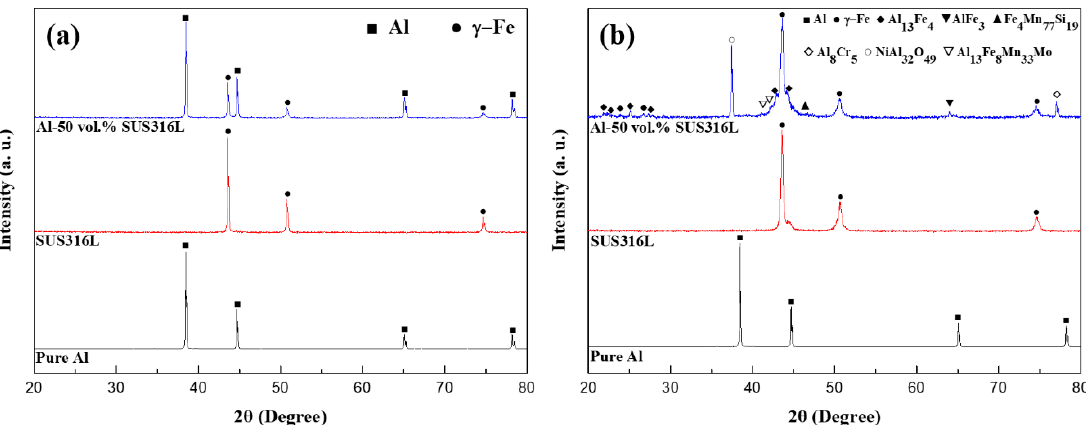
Figure 3. XRD patterns of ( a ) pure Al, SUS316L, and Al-50 vol.% SUS316L powders, ( b ) pure Al and